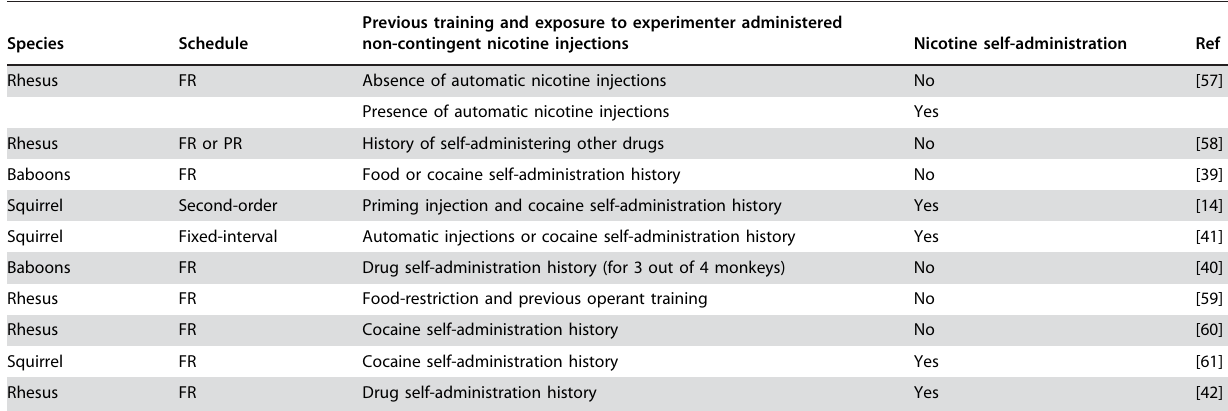
Table 1. Summary of previous studies evaluating intravenous nicotine self-administration behavior in non-human primates. .. ... .... ... ... .... ... ... .... ... ... .... ... ... .... ... ... .... ... ... .... ... ... .... ... ... .... ... ... .... ... ... .... ... ... .... ... ... .... ... ... .... ... ... .